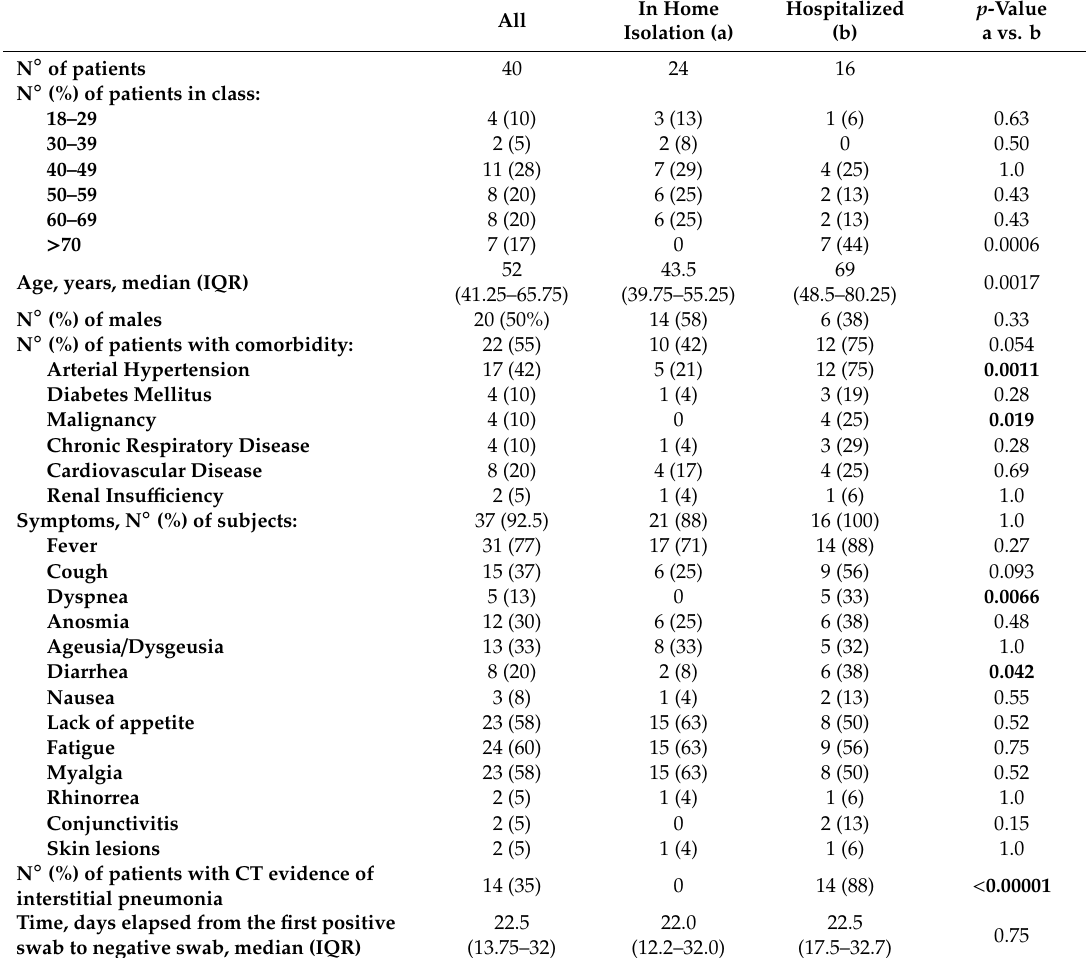
Table 1. Demographic and clinical characteristics of the patients enrolled.